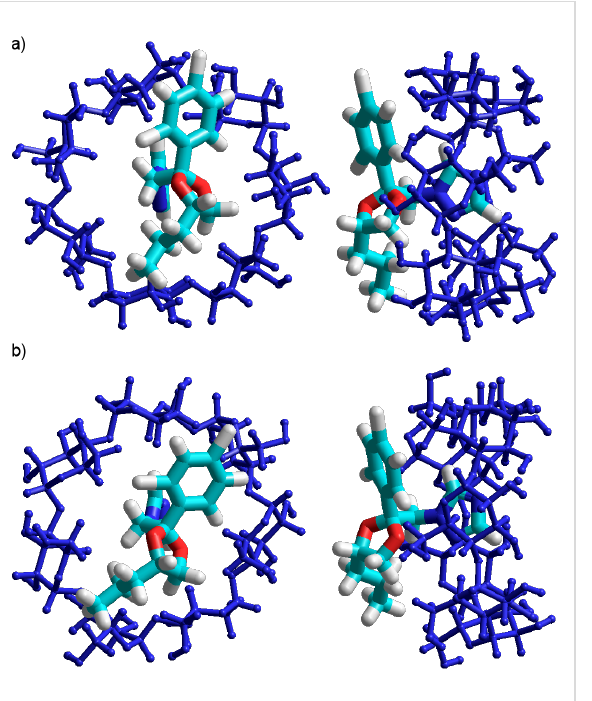
Figure 5: PM3 optimized molecular geometry of the β -CD/PP inclu- sion compounds in (a) A configuration and in (b) B configuration.